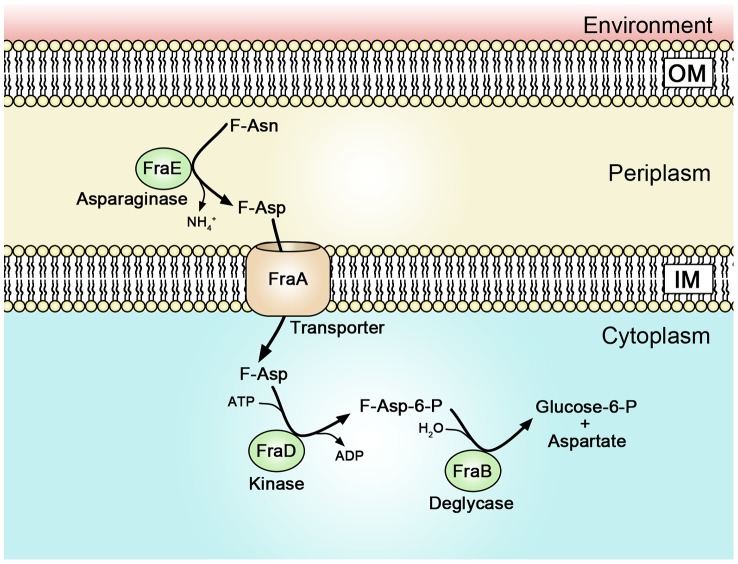
A proposed model of Fra protein localization and functions.A proteomic survey of subcellular fractions of Salmonella previously identified FraB (the deglycase) as cytoplasmic and FraE (the asparaginase) as periplasmic [79]. Therefore, it is possible that F-Asn is converted to F-Asp in the periplasm by the asparaginase and that the transporter and kinase actually use F-Asp as substrate rather than F-Asn. The FraD kinase of Salmonella shares 30% amino acid identity with the FrlD kinase of E. coli. FrlD phosphorylates F-Lys to form F-Lys-6-P [28]. Therefore, we hypothesize that FraD phosphorylates F-Asp to form F-Asp-6-P. The FrlB deglycase of E. coli shares 28% amino acid identity with FraB of Salmonella. The FrlB deglycase converts F-Lys-6-P to lysine and glucose-6-P [28], so we hypothesize that FraB of Salmonella converts F-Asp-6-P to aspartate and glucose-6-P.